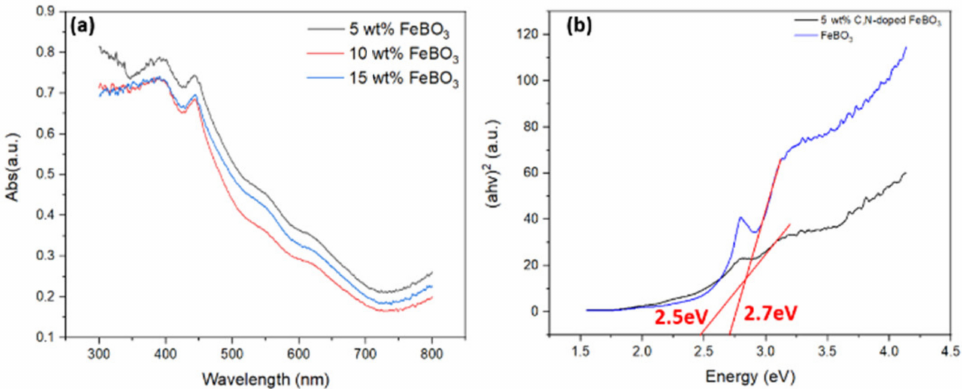
Figure 5. ( a ) The UV-DRS spectra of the C,N-doped FeBO 3 with various iron contents, and ( b ) the Tauc plots of the C,N-doped FeBO 3 with 5 wt.% iron nanoparticles (black line) and the pristine FeBO 3 (blue